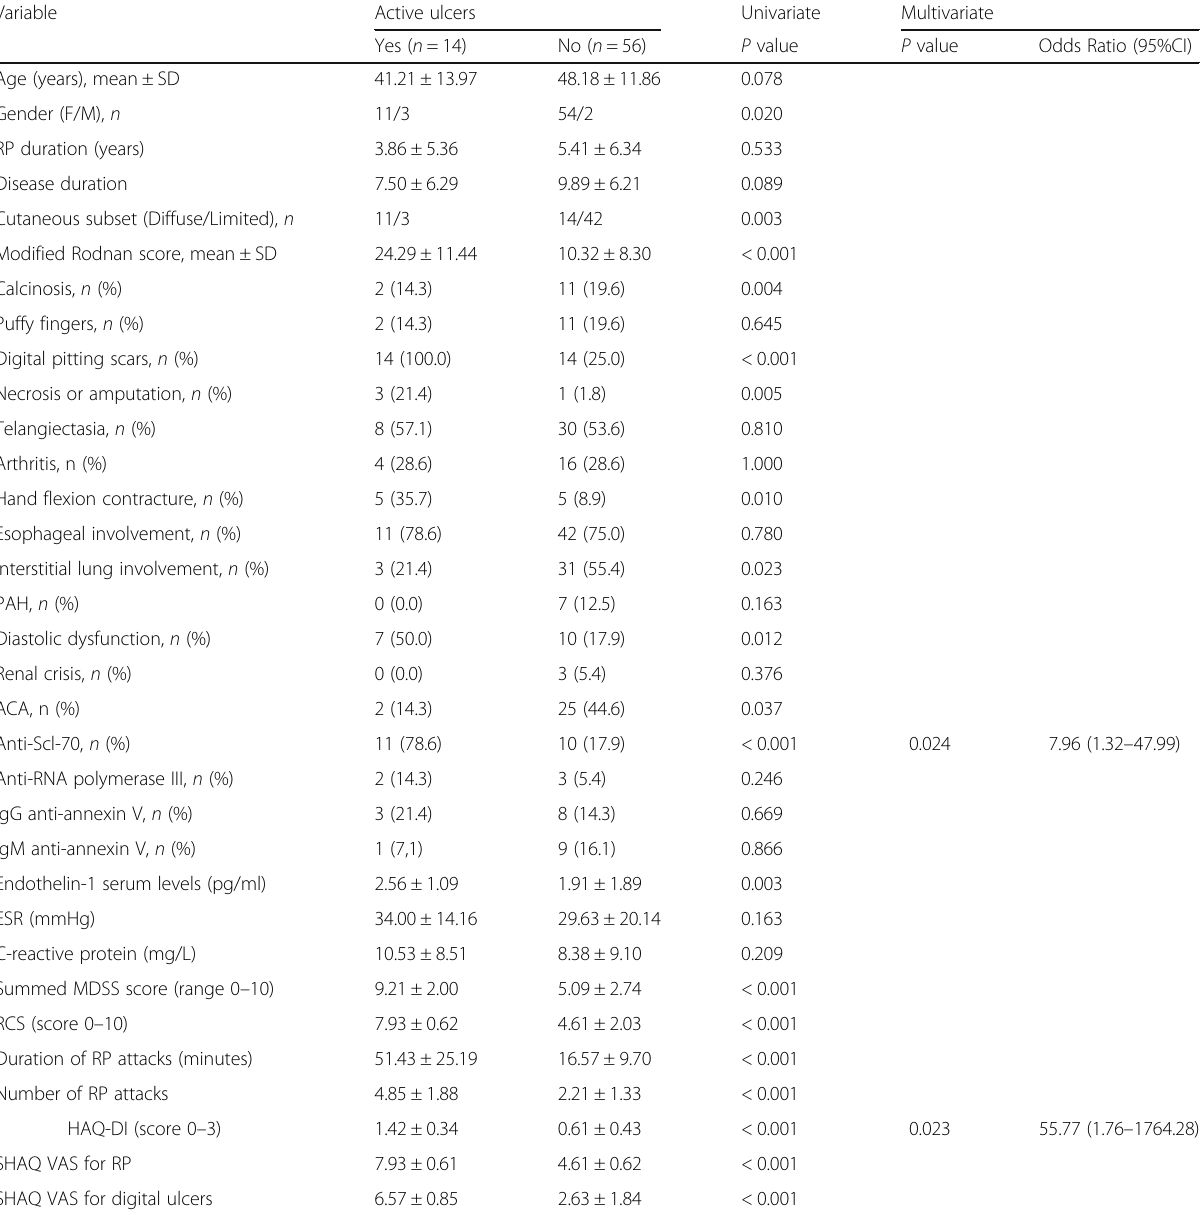
Table 2 Univariate and multivariate analysis for risk factors for the development of digital ulcers Variable Active ulcers Univariate